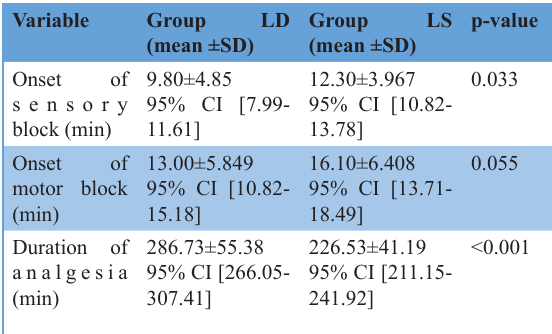
Table 3. Comparison of the characteristics of block and duration of analgesia between two groups